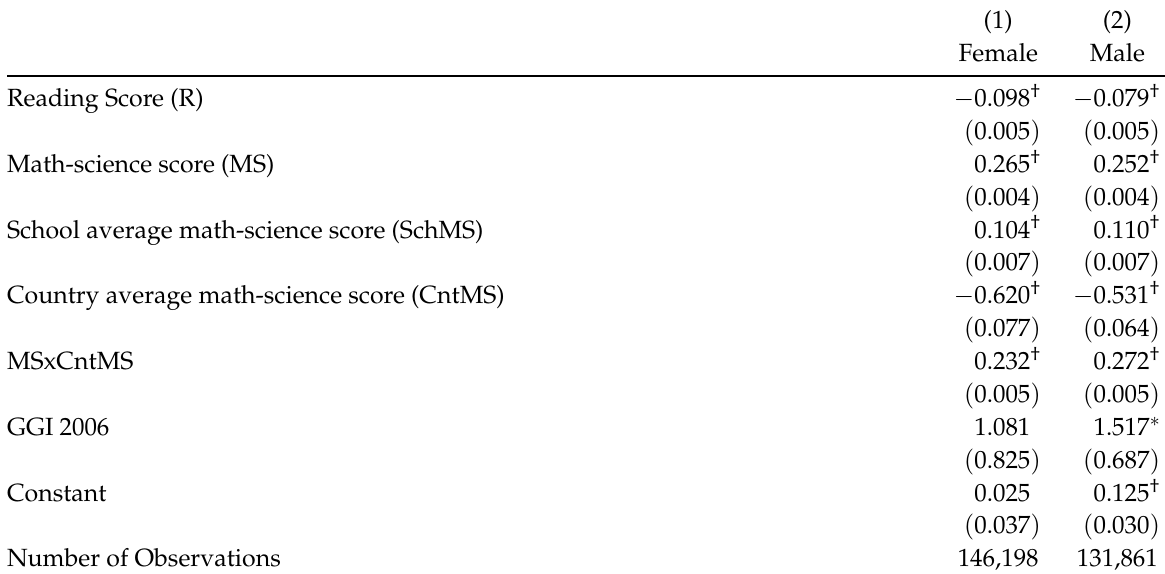
Table 1: Regression of Self-Assessment on Individual- and Country-Level Measures and Random Country